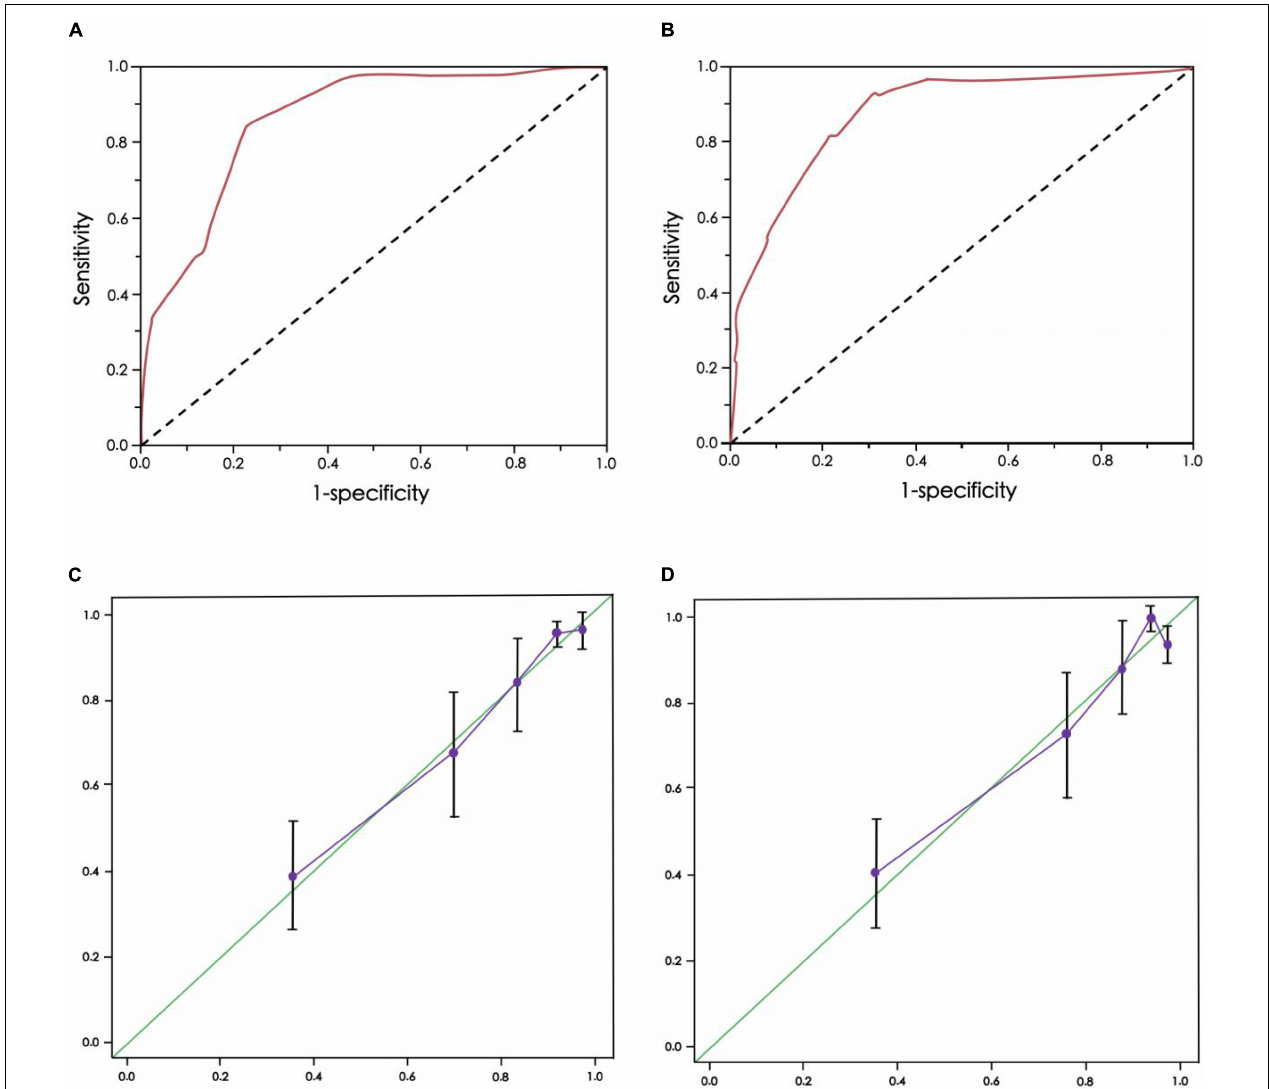
FIGURE 2 | Receiver operating characteristic (ROC) curve and calibration chart of CEUS+ scoring system model for predicting the risk of renal function deterioration in patients. (A) ROC curve of training group, (B) ROC curve of verification group, (C) Calibration chart of training group, (D) Calibration chart of verification